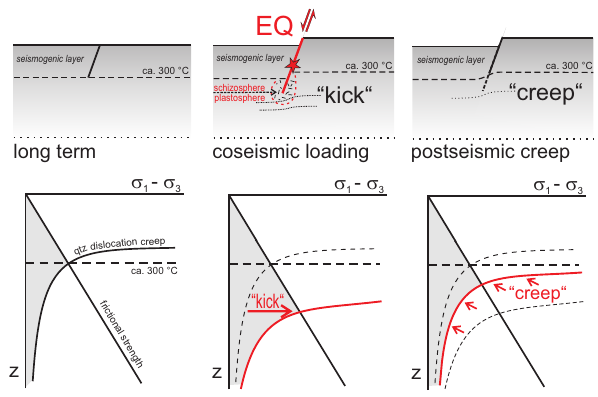
Fig. 1. Stress and strain rate changes during the seismic cycle, visualized by hypothetical crustal strength profiles (not to scale). Hypocentre is marked by asterisk. Around the lower termination of the downward propagating rupture plane of a large earthquake, i.e. at the boundary between schizosphere and plastosphere sensu Scholz (2002), quasi-instantaneous coseismic loading to high dif- ferential stress causes deformation of quartz in the low-temperature plasticity regime (“kick”). During subsequent stress relaxation and restoration of long-term state, quartz deforms by dislocation creep at decaying strain rate (“creep”), each stage of the earthquake- related stress cycle leaving a characteristic microstructural imprint. In the present study, modification of microstructures acquired dur- ing the “kick” stage in the course of subsequent “creep” deforma- tion is investigated in laboratory